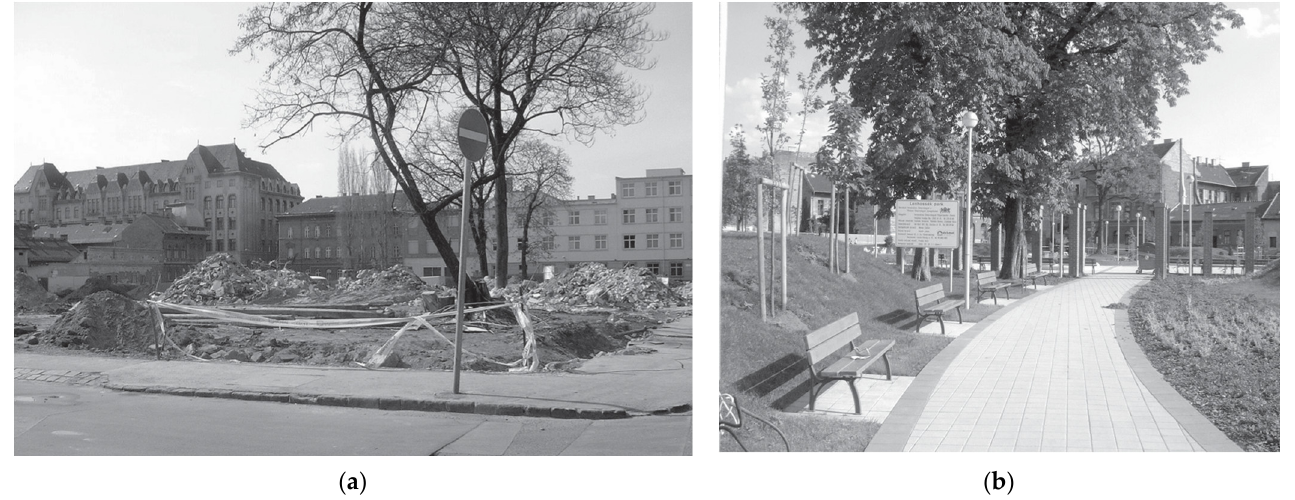
Figure 2. ( a ) Process of establishing the Kerekerdő park from the agglutination of empty plots and the demolition of residential buildings [14]; ( b ) Kerekerdő park already in use in the early 2000s. The public space was designed to prioritize the integration of the territory and promote accessibility to green areas and playgrounds [14].